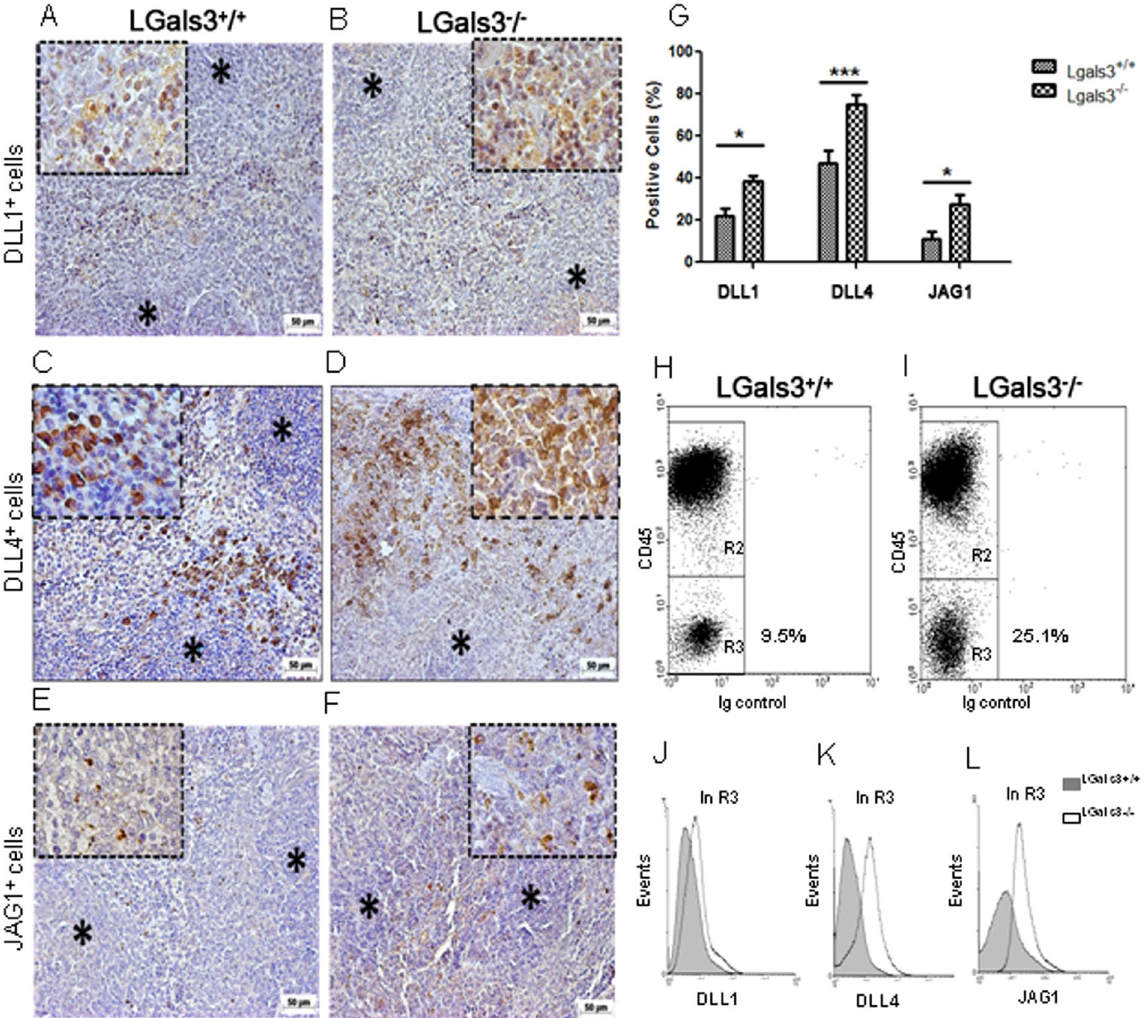
Figure 5. Localization of Notch-ligands expressing cells in the spleen. ( A ) DLL1 + cells in extrafollicular sites of Lgals3 + / + mice. ( B ) DLL1 + cells atypically distributed on Lgals3 − / − mice. ( C ) DLL4 + cells in well defined sites in Lgals3 + / + mice and ( D ) disorganized in Lgals3 − / − mice. ( E ) JAG1 + cells on extrafollicular regions of Lgals3 + / + mice and randomly distributed in Lgals3 − / − mice ( F ). ( G ) Percentage of splenic cells according positivity to DLL1, DLL4 and JAG1. Dot plot graphs by flow cytometry identify hematopoietic (CD45 + ) cells and stromal (CD45 − ) cells in both Lgals3 + / + and Lgals3 − / − mice (H and I, in R3, respectively). Histograms indicate the intensity of expression of DLL1 ( J ), DLL4 ( K ) and JAG1 ( L ) in both groups of mice. n = 5 mice per group. Magnification: ( A – F ) 100 × ; inserts 400 × ; DLL1 = Delta-like 1, DLL4 = Delta-like 4 and JAG1 = Jagged-1. ( * ) Indicates p < 0.05. ( *** ) Indicates p <